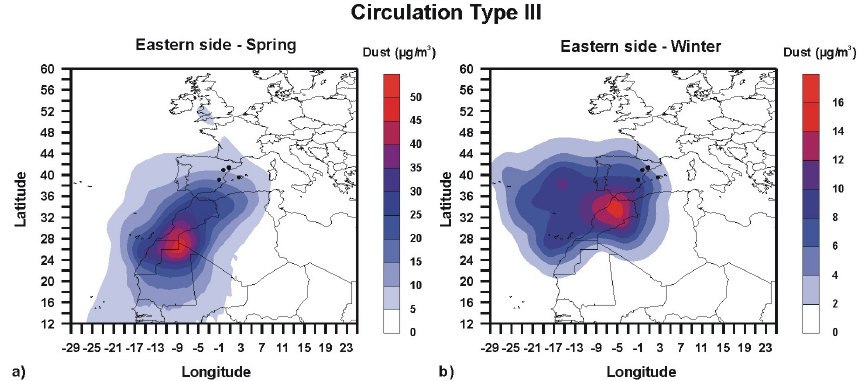
Figure 12. RCFs for African dust contributions (µgm − 3 ) during ADO generated by circulation type III over the eastern side of the area of study in spring and winter.